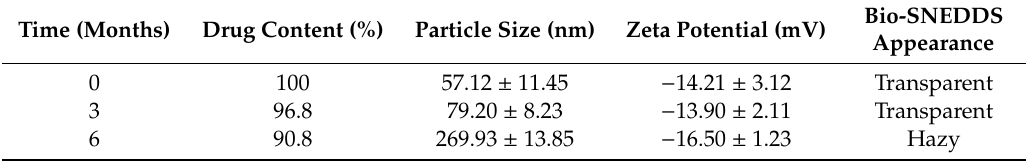
Table 5. Time-dependent stability studies showing the drug recovery after three and six months at 40 ◦ C and 75% relative humidity (RH). An amount of 10 mg of APG, which was 80% of the equilibrium solubility of the Bio-SNEDDS formulation F11-CoFA: CMCM: TC (3:1:1) / HCO30 [1 / 1], was kept in the incubator for the stability